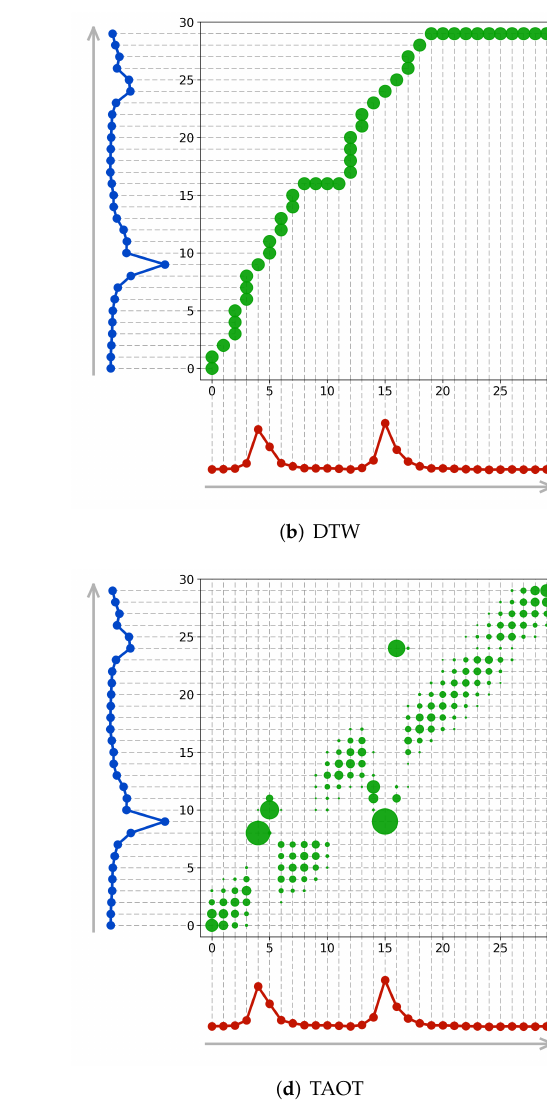
Figure 2. Examples of alignments generated by different similarity measures. ( a ) Euclidean distance; ( b ) DTW; ( c ) OT; ( d )